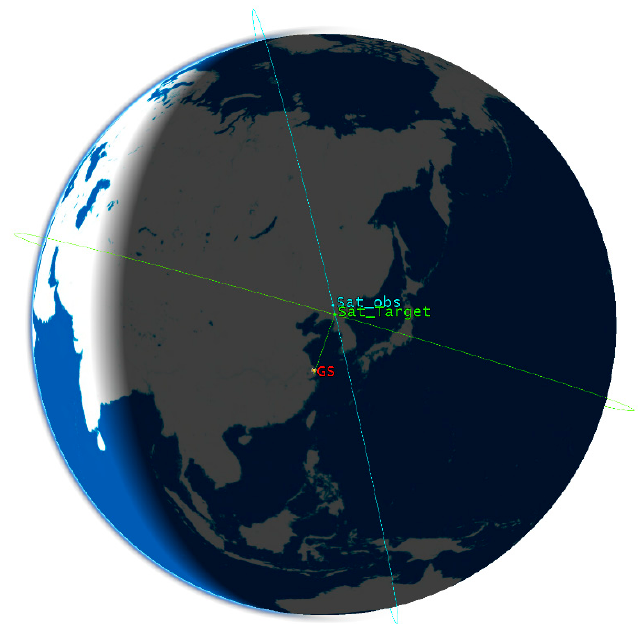
Figure 4. Calculation example scene.